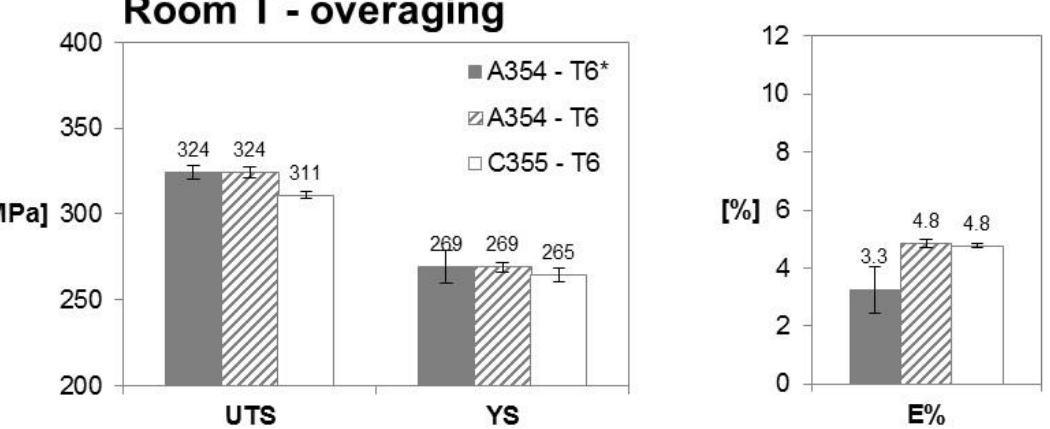
Figure 12. Tensile properties of A354-T6*, A354-T6, and C355-T6 alloys at room temperature in the overaged condition. After heat treatment, the alloys were subjected to soaking at 210 °C for 50 h (A354-T6*) and 41 h (A354-T6 and C355-T6), which is readapted from Reference [21].